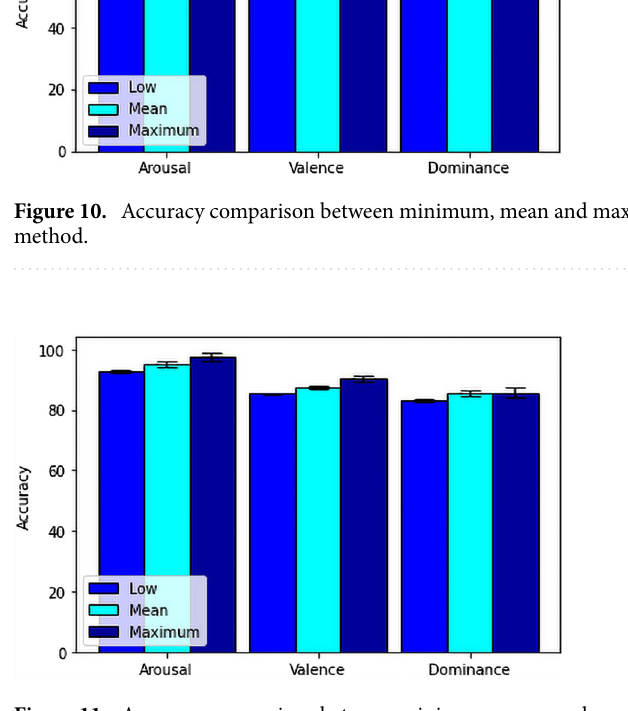
Figure 11. Accuracy comparison between minimum, mean and maximum of the feature fusion-based XGBoost method.